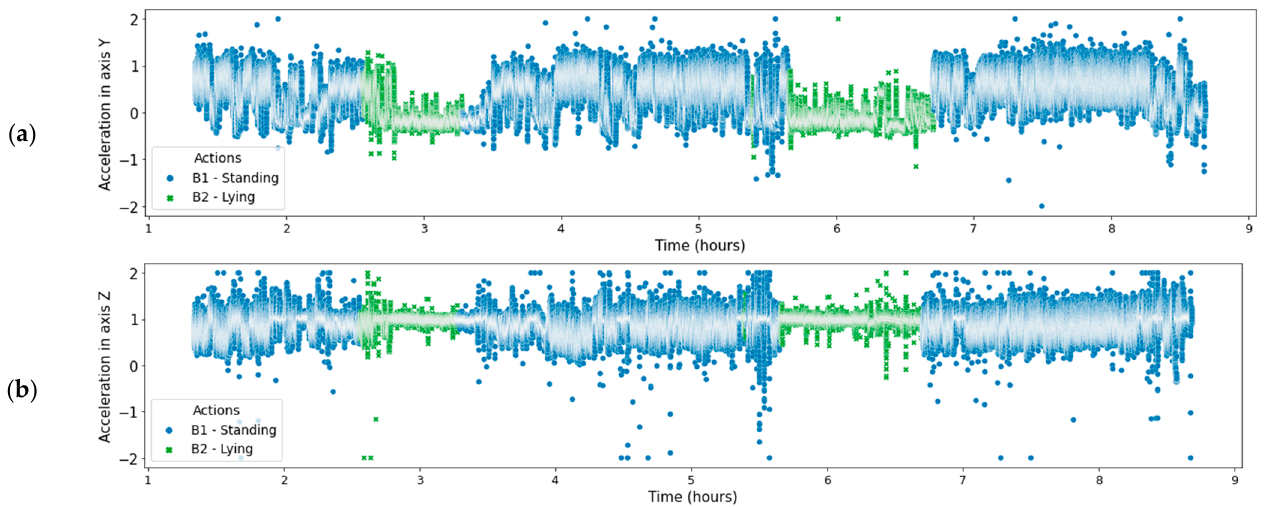
Figure 6. Y-axis and Z-axis accelerometer signal with human-labelled standing and lying annotations. ( a ) Y-axis; ( b ) Z-axis.